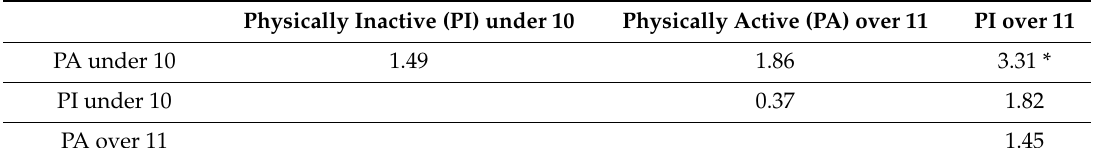
Table 9. Results for Gabriel’s post hoc